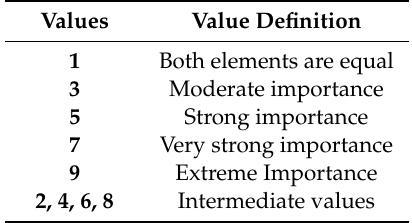
Table 1. Judgment scale (Saaty’s 1–9 scale)